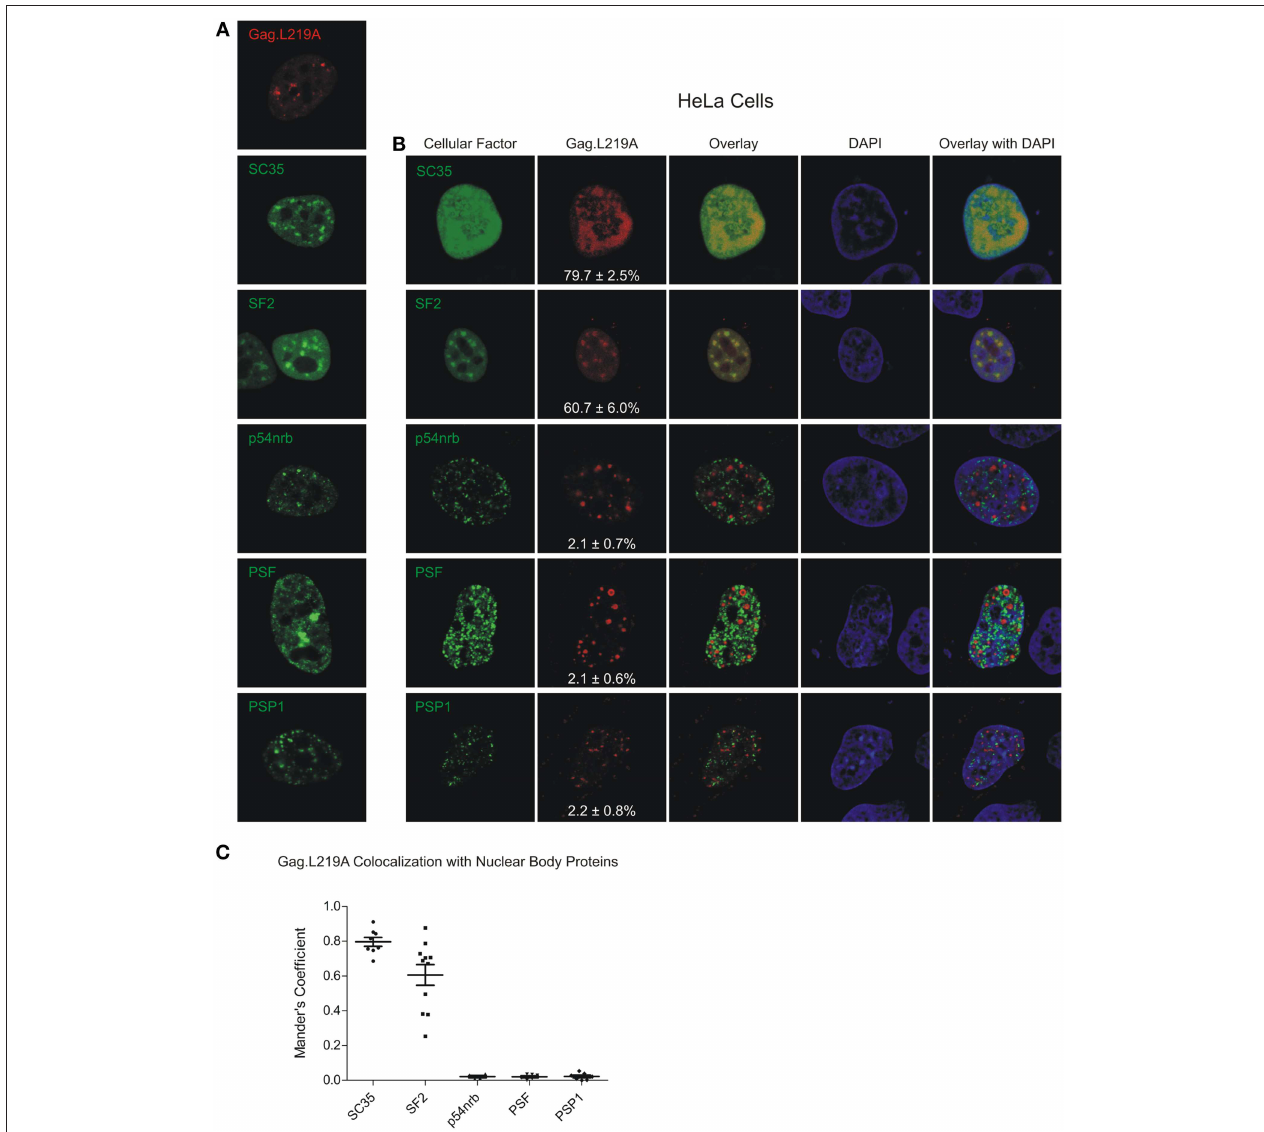
FIGURE 3 | Localization of Gag.L219A with host nuclear body proteins in HeLa cells. (A) Localization of Gag.L219A and nuclear body proteins in singly transfected HeLa cells (B) Co-localization analysis between Gag.L219A and the indicated nuclear body proteins in co-transfected HeLa cells. Merging of Gag.L219A and nuclear body marker protein channels is displayed (Overlay). The DAPI channel is also depicted. The percentage of Gag.L219A with each factor is depicted in the Gag.L219A channel with the standard error of the mean. (C) Scatterplot depicting the mean and standard error of the mean of Gag.L219A co-localization with each of the nuclear body